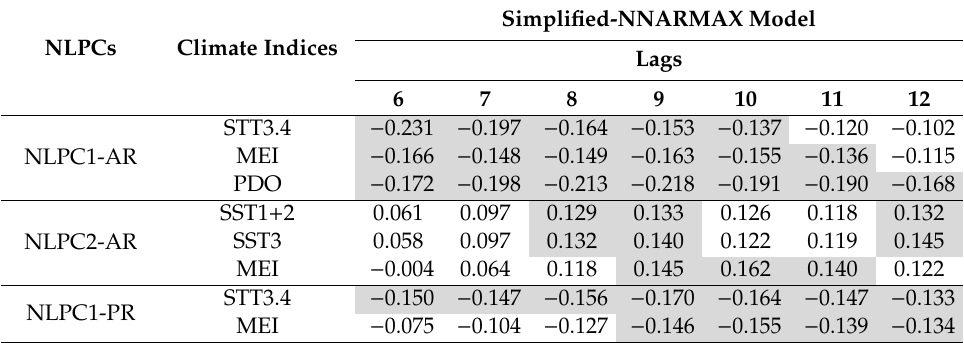
Table 3. Exogenous variables selected as predictors in the Simplified-NNARMAX Model for NLPC1-AR, NLPC2-AR, and